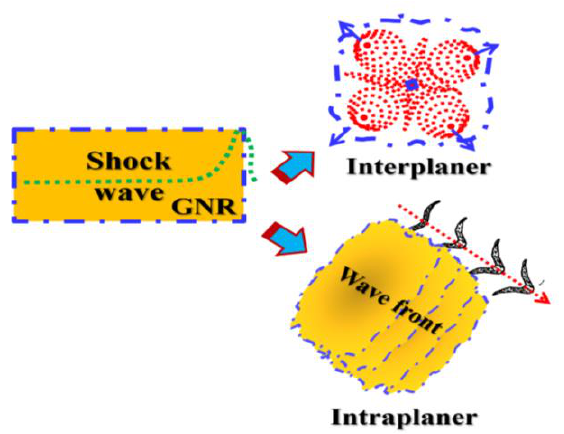
Figure 6. Scheme of effect of impulse pressure on the GLNRs within layer and layer conjugation. Table 1. Estimated dynamic mechanical parameters for the GLNRs from Hugoniot formalism. Sr. No. Parameter (SI